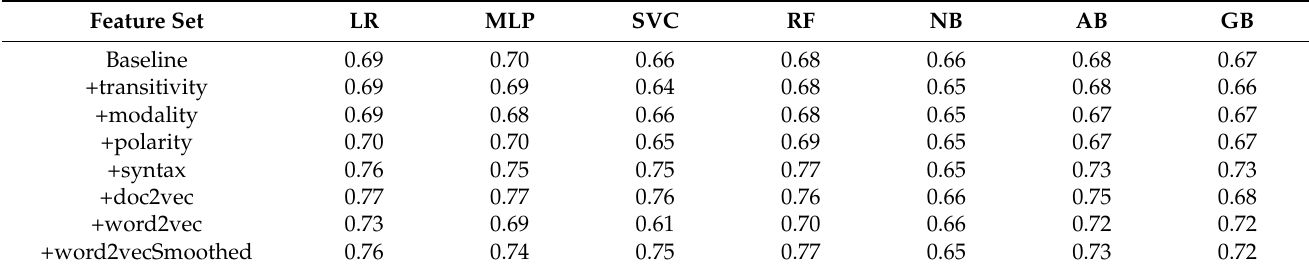
Table 1. Classification of problems from non-problems using ML classifiers by training data iteration. Feature